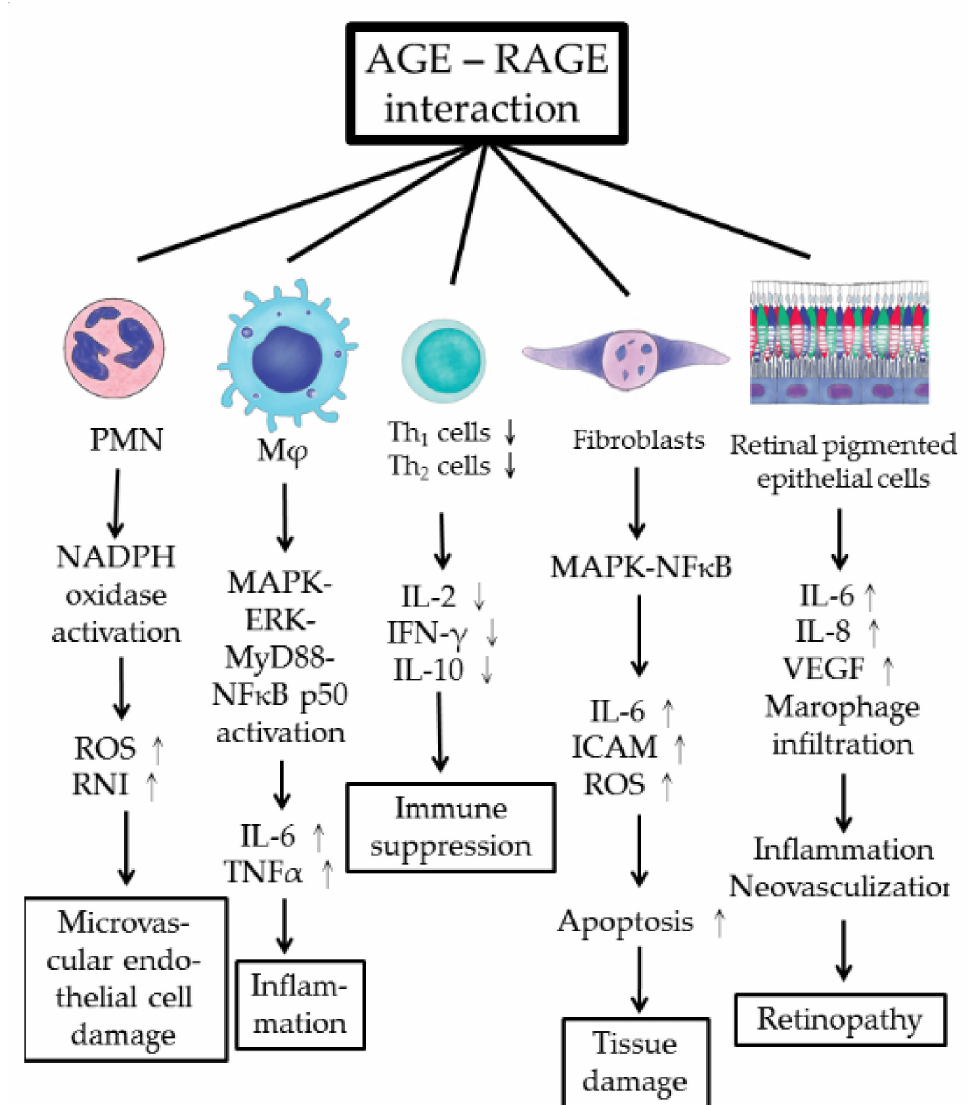
Figure 3. Cellular and molecular pathogenesis of AGE–RAGE axis activation in inducing microvascular endothelial cell damage, tissue inflammation, immune dysfunction, tissue fibrosis, and retinopathy. RPEC: retinal pigmented epithelial cell; ROS: reactive oxygen species; RNI: reactive nitrogen intermediates; ICAM: intercellular adhesion molecule; VEGF: vascular endothelial cell growth factor. 4.2. AGE E ff ects on Microvascular Endothelial and Smooth Muscle Cell Damage in Diabetic